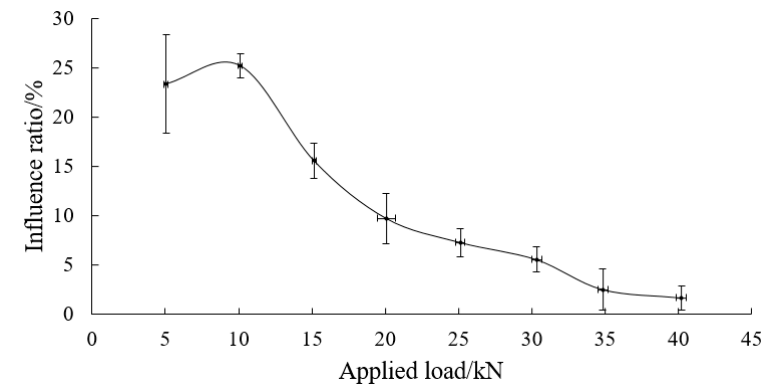
Figure 22. The relation curve between the applied load and the change rate of axial force of FBG1 in “Passive”.